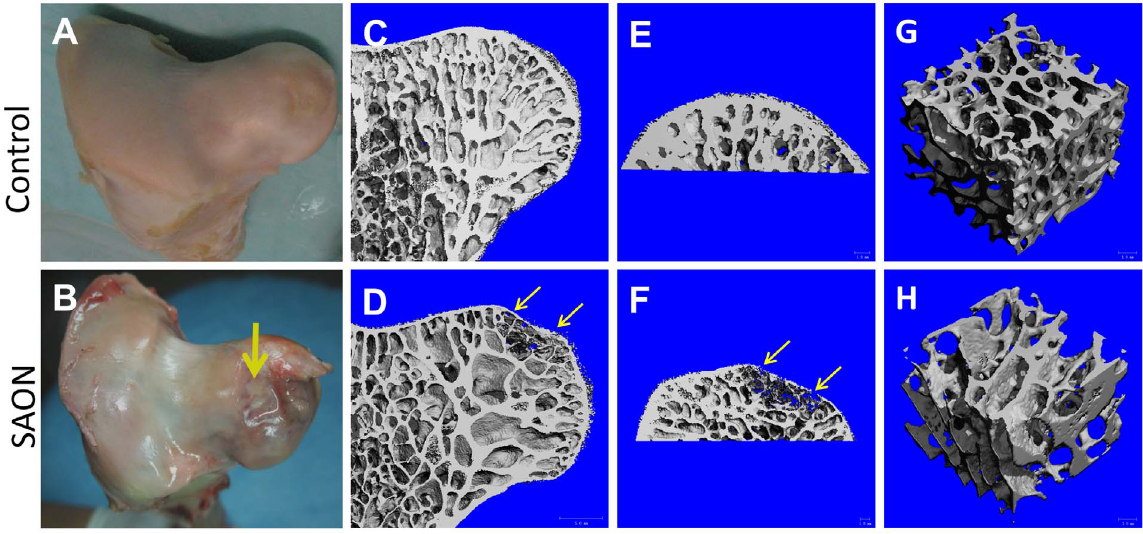
Figure 4. Gross observation of femora head and its micro-CT analysis compared between the control and SAON emus. (A) and (B): representative femoral head in the control group and SAON group, respectively with collapsed femoral head in SAON group (yellow arrow); (C) and (D): representative microCT images of normal femoral head in the control group and of collapsed femoral head in SAON group, respectively; (E) and (F): representative microCT images of subchondral bone in the control group and SAON group, respectively; (G) and (H): representative microCT images of trabecular bone in the central part of the femoral head in the control group and SAON group, respectively. Yellow arrow: collapsed region.